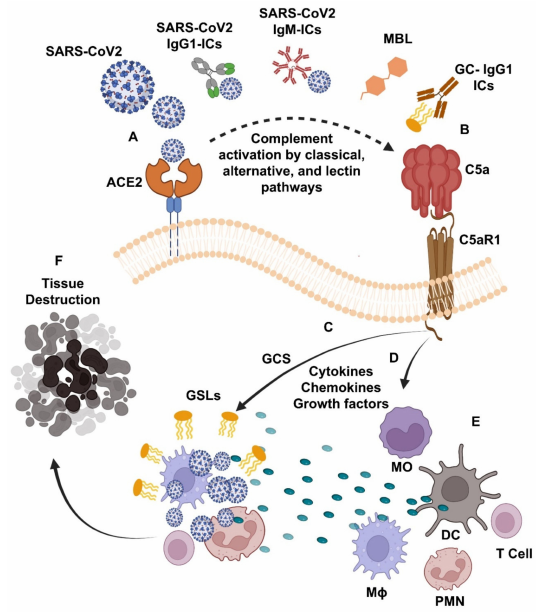
COVID-19 (Coronavirus disease 2019), MERS-CoV (Middle East Respiratory Syndrome Corona- virus), SARS-CoV-1 (Severe Acute Respiratory Syndrome Coronavirus-1), SARS-CoV-2 (Severe Acute Respiratory Syndrome Coronavirus-2), AECs (Airway epithelial cells), M ɸ s (Macrophages), DCs (Dendritic cells), PMNs (Polymorphonuclear cells), NK (Natural Killer cells), IFN (interferon), α (alpha), β (beta), γ(gamma), λ (lambda), IL (interleukin), TNF (tumor necrosis factor), CCL (Chem- okine (C-C motif) ligand), CXCL (Chemokine (C-X-C motif) ligand), PBMCs (Peripheral Blood Mon- onuclear Cells), PCs (Pulmonary Cells), MAC (Membrane Attack Complex; MAC), C3a (Comple- ment 3a), C3b (Complement 3b), C3aR (Complement 3a Receptor), C5a (Complement 5a), C5aR1 (C5a Receptor 1), sC5b-9 (soluble C5b-9; MAC); C4d (Complement 4d). C3bBbP (complement 3 b bound protease fragment), C3bc (Complement 3 bc), P (Protein expression level), M (mRNA expres- sion level) + (low), ++ (moderate), and +++ (high), NS (not significant). ), dendritic cell (DC), T cells, and